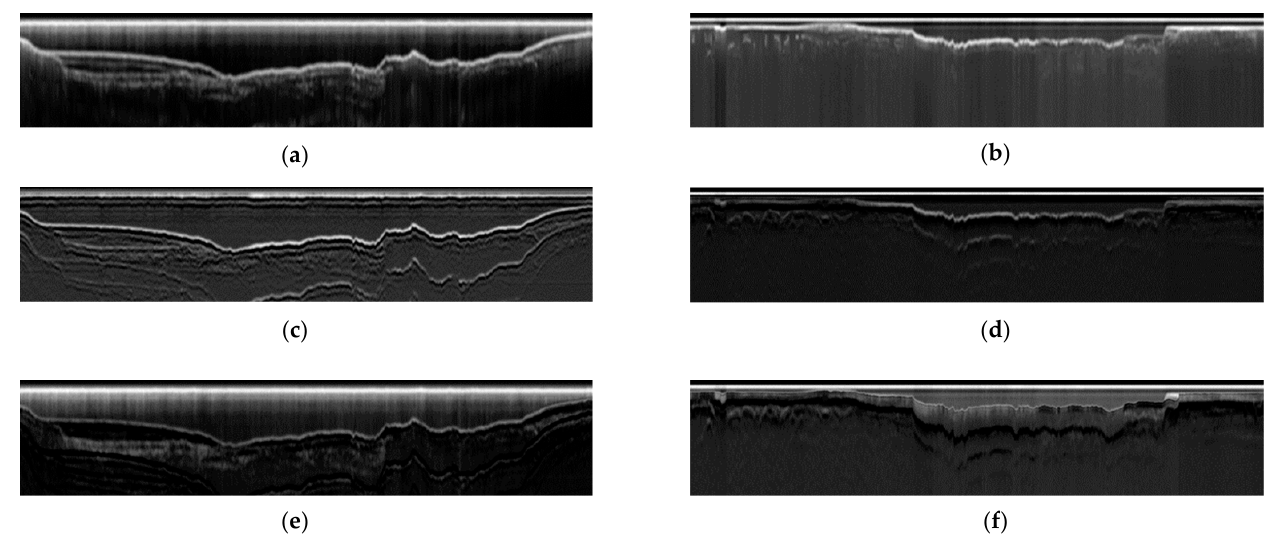
Figure 18. Comparison of multiple suppression results. ( a , c , e ) represent SBL_20120628_085229. ( b , d , f ) represent SBL_20160305_025613. ( a , b ) are the results of the proposed multiple suppression method. ( c ~ f ) are the results of predictive deconvolution. The predictive step of ( c , f ) is 25, and the step of ( e , f ) equals instantaneous seawater depth.